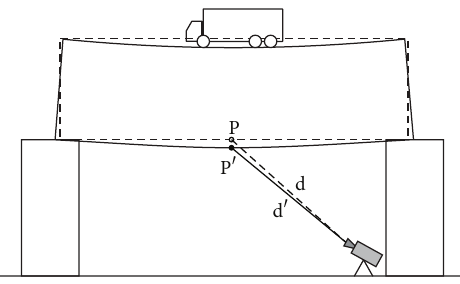
Figure 12: Radar installation on the riverbed.